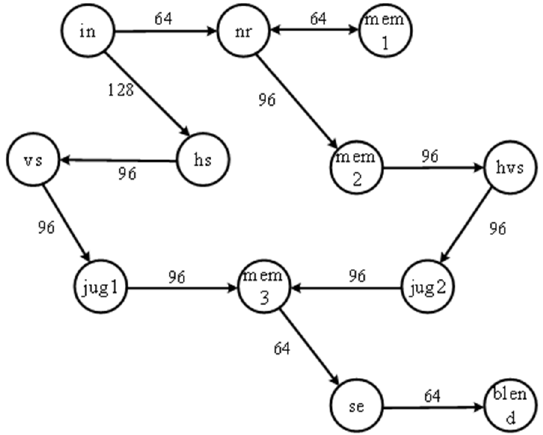
Figure 2. Communication task of multi-window display chiplets.